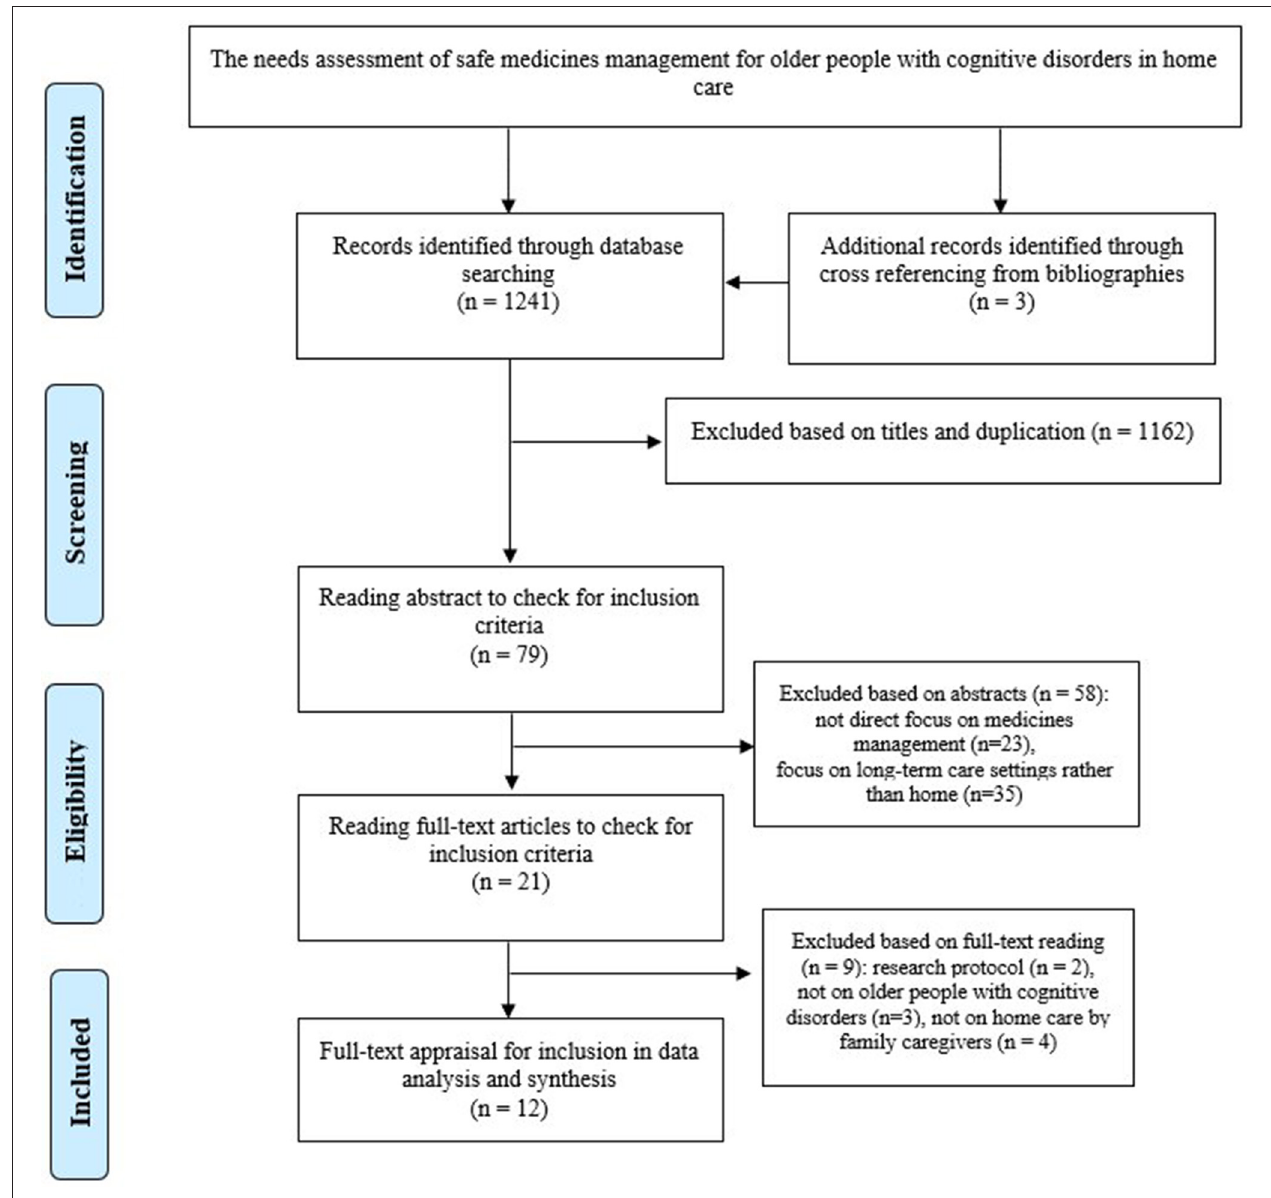
FIGURE 1 | The Preferred Reporting Items for Systematic Reviews and Meta-Analyses